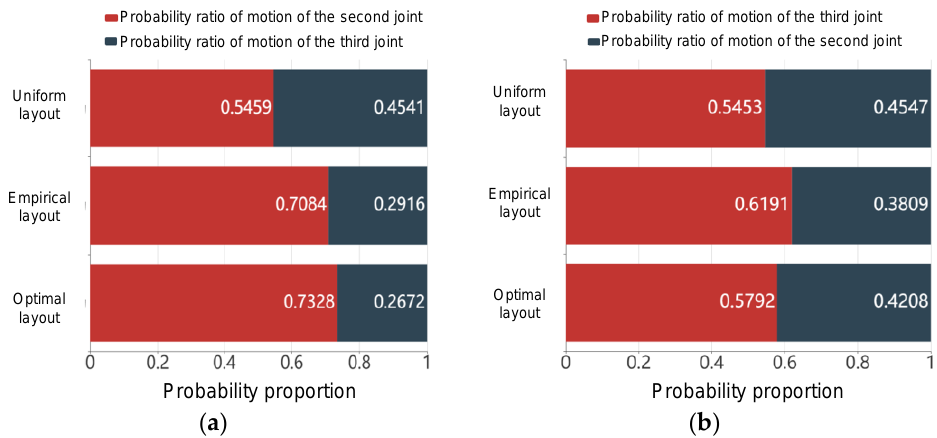
Figure 9. Probabilistic verification of three layouts: ( a ) Probability verification of the second joint in motion, ( b ) Probability verification of the third joint in motion.